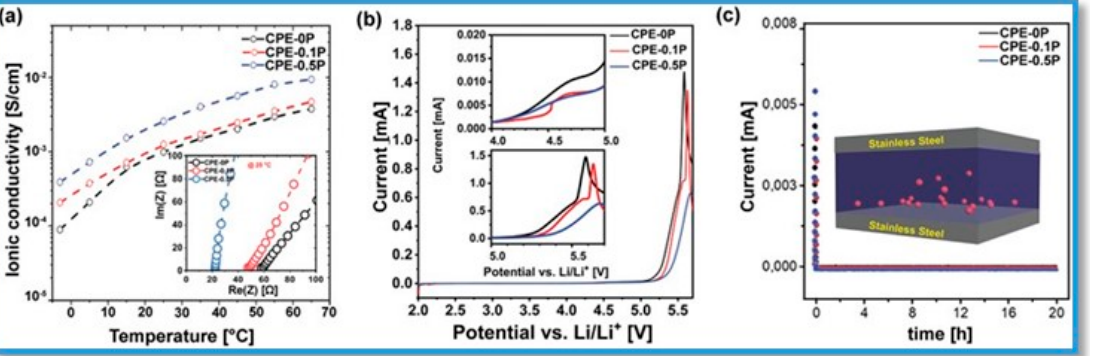
Figure 14. Electrochemical evaluation of the developed electrolytes. ( a ) Ionic conductivity as a function of temperature for CPE–0P, CPE–0.1P, and CPE–0.5P. The inset graph shows the Nyquist plots corresponding samples at 25 °C. ( b ) Linear sweep voltammetry showing electrochemical stability window. ( c ) Direct current polarization tests to measure the electronic conductivity of the developed